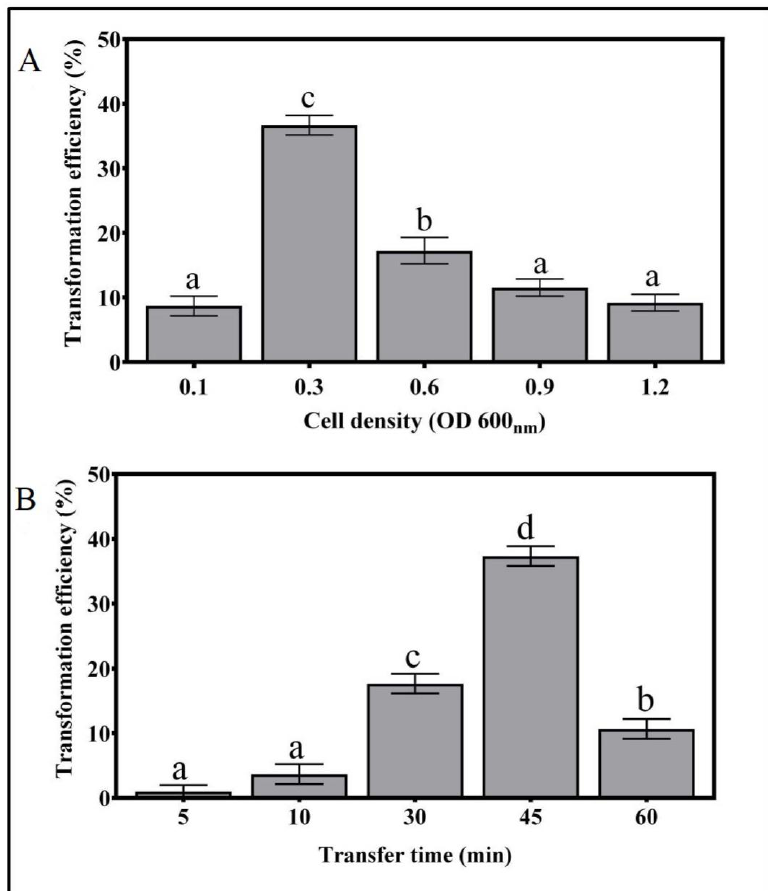
Figure 2. Effects of A. tumefaciens cell density ( A ) and transfer time ( B ) on the T. boudieri transformation efficiency. For each treatment 100 mycelia cylinders were infected with Agrobacterium . Values are mean ± SE ( n = 3), and letters denote significant differences (p = 0.05).